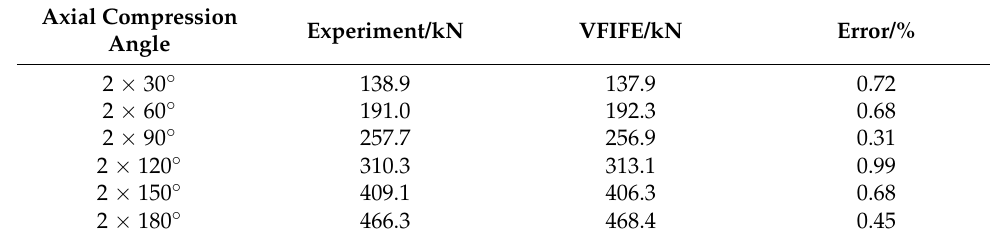
Table 2. Comparison of results.